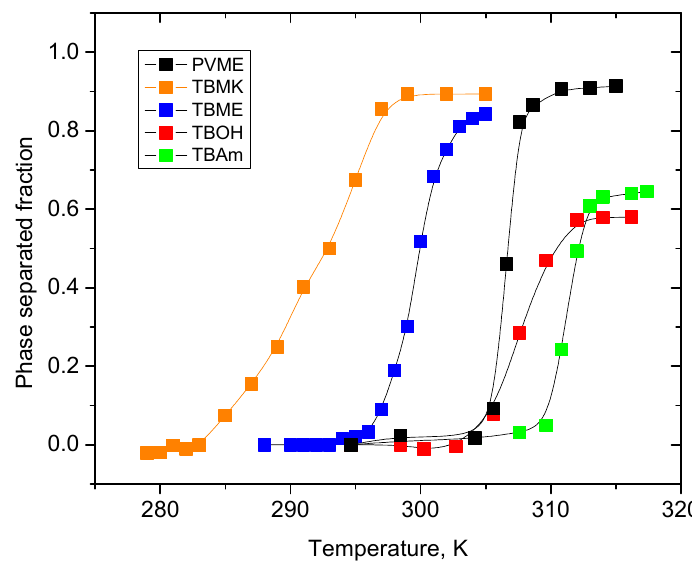
Figure 3. Temperature dependences of the fraction p as obtained from integrated intensities of CHOCH 3 protons of PVME in neat PVME solution ( c P = 5 wt % in D 2 O) and PVME/additives solutions ( c P = 5 wt %, c ad = 5 wt % in D 2 O).